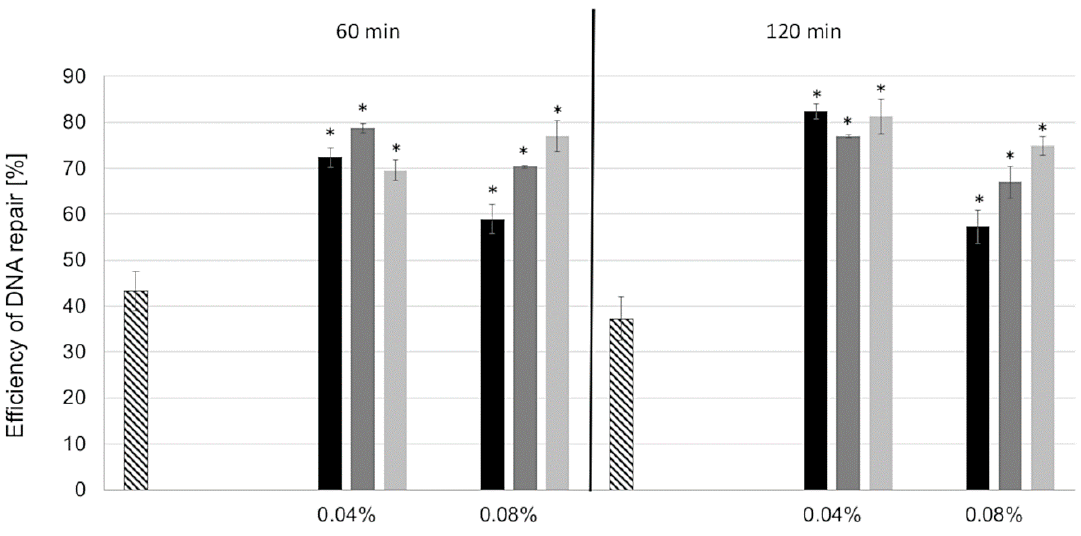
Figure 6. Efficiency of DNA repair in Caco-2 cells exposed to different IC 0 concentrations (0.04% and 0.08%) of Aronia melanocarpa, Cornus mas, and Chaenomeles superba leaf extracts. DNA repair was measured at 0 min, after 60 and 120 min of incubation. The number of cells analysed for each time-interval was 50. Error bars denote S.E.M. (*) statistically significant differences from the positive control (ANOVA ( p < 0.05)).